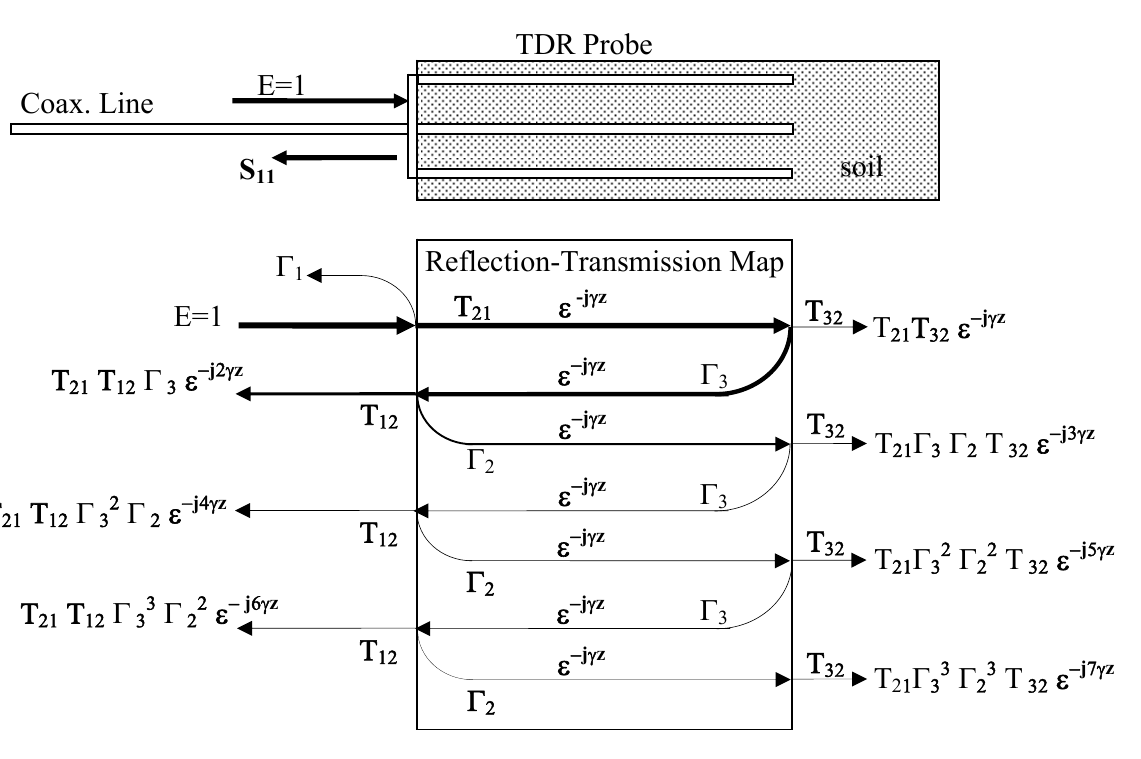
Figure 1. Detail of resultant waveform from combination of multiple reflections from both the leading edge, undesired, and probe end, desired measurement, in TDR/FDR probes due to impedance miss-match between coaxial cable impedance Zo to the soil-probe impedance Z1. Note: Hatched area indicates soil or other material under